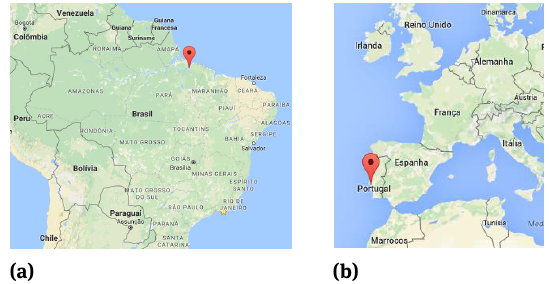
Figure 1: Relative location of the cities of Belém, Brazil (a), and Lis- bon, Portugal